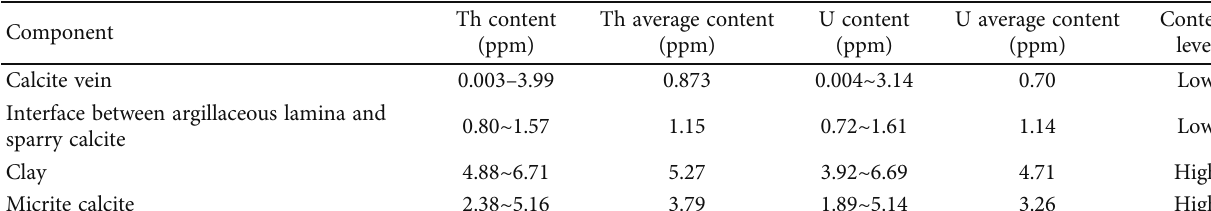
Figure 5: Distribution curves of major and trace elements in laminated argillaceous sparry limestone. Table 1: Th and U contents of the four components.